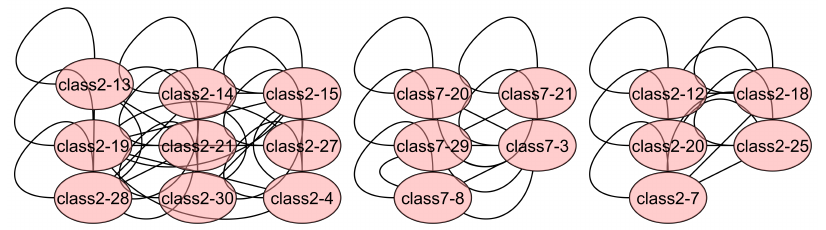
Figure 6. Subgraphs of Laplacian matrix from Botswana